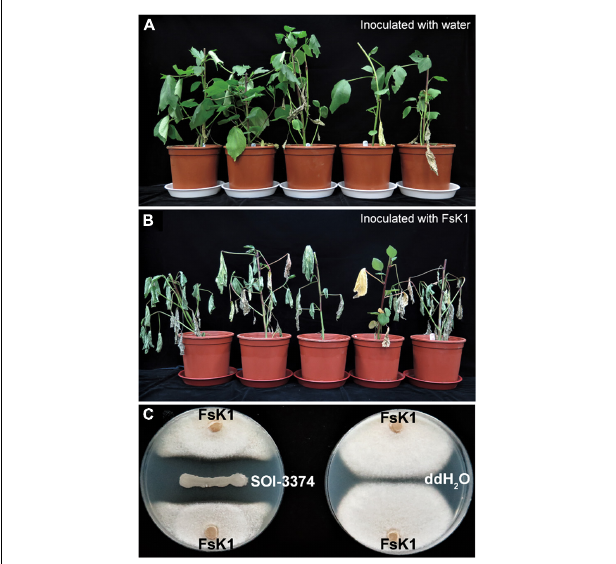
FIGURE 4 | Fusarium solani K1 (FsK1) can cause roselle wilt disease. (A) Three-week-old roselles remained healthy after inoculation with ddH 2 O. (B) Those inoculated with the conidia of FsK1 exhibited wilting symptoms. (C) SOI-3374 showed antagonistic activity against FsK1 compared to ddH 2 O